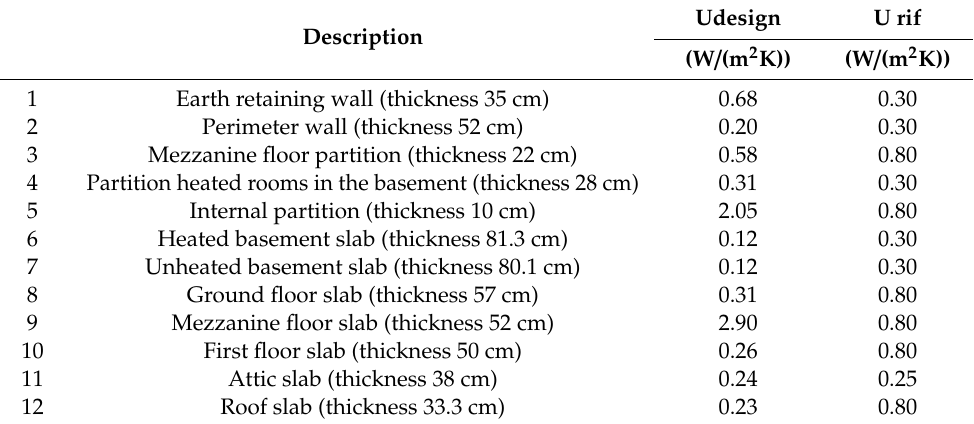
Table 1. List of stratigraphic packages with thermal transmittance checks.